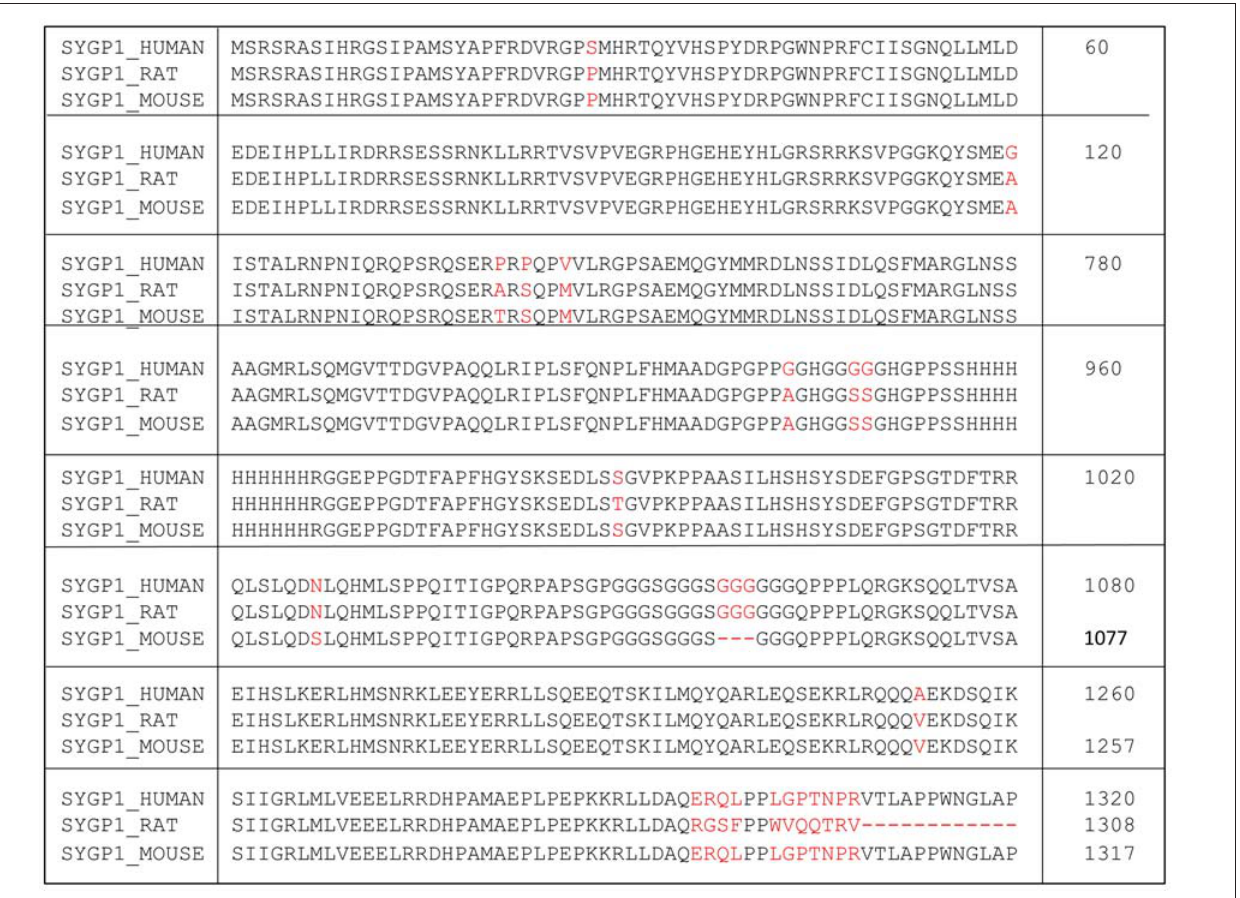
FIGURE 1 | Amino acid sequence of human SYNGAP1 and its difference with mouse SYNGAP1. Amino acid sequence differences of SYNGAP1 between Homo sapiens (SYGP1_Human), Rattus rattus (SYGP1_RAT) and Mus musculus (SYGP1_MOUSE). Variations in the sequences were indicated in red colored fonts. Dashed line indicates empty